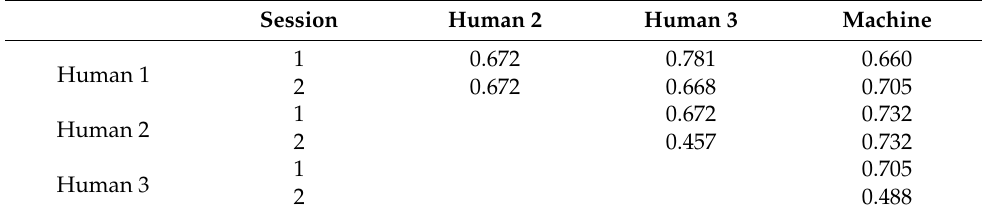
Table 3. The interrater Cohen’s kappa